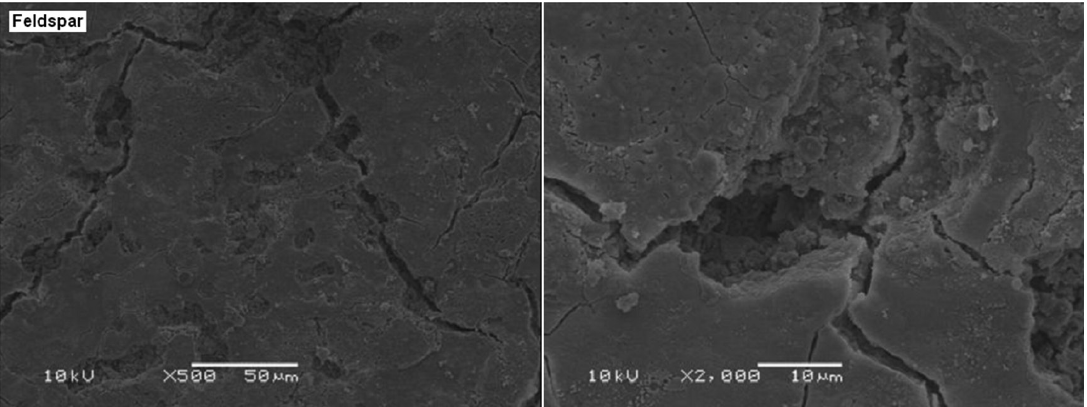
Figure 5. Images (SEM): chemical etching (20%HF, 20 s); Feldspar body fired at 1240 °C.